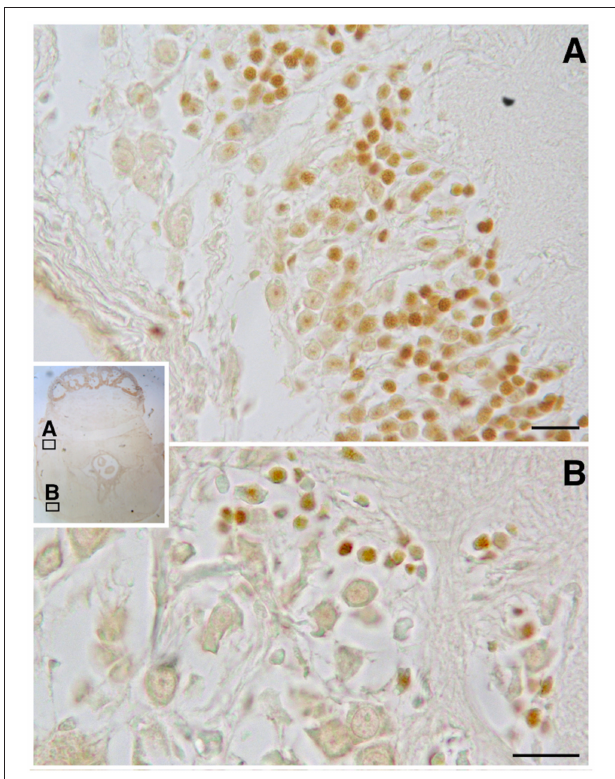
FIGURE 3 | BrdU immunoreactivity on transversal section of O. vulgaris central nervous system suboesophageal mass: A – palliovisceral lobe showing several interneuron nuclei labeled; B – posterior pedal lobe with few scattered immunopositive interneuron nuclei (scale bar = 50 µ m).